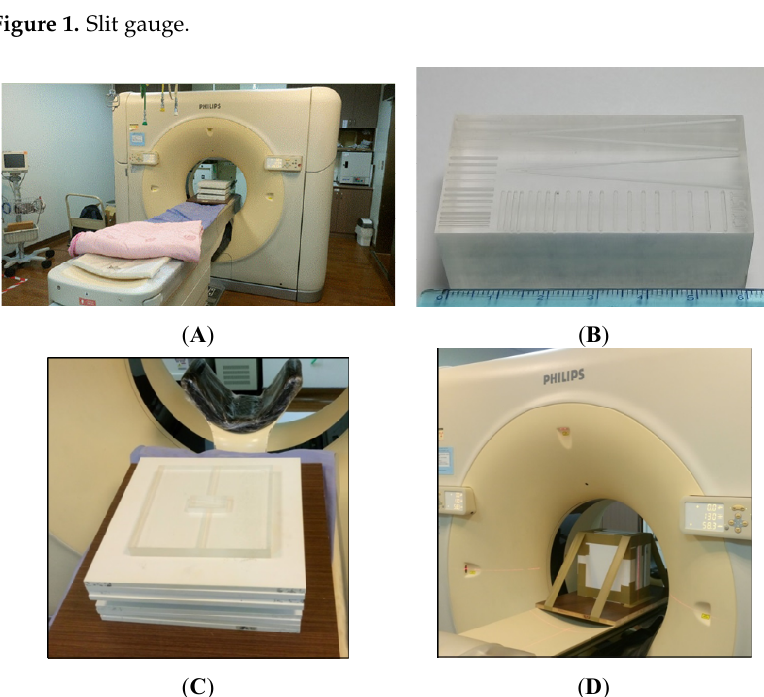
Figure 2. ( A ): Slit gauge under 128-slice brain CT examination. ( B ) Detailed view of the slit gauge. The slit gauge was placed in the center of three solid water plates (300 × 300 × 40 mm 3 ). The thickness of each of the upper, middle, and bottom plates was 4, 4, and 4 cm for ( C ) horizontal and ( D ) vertical verification. The slit gauge was assembled using several solid water plates to simulate an adult head for CT scanning.